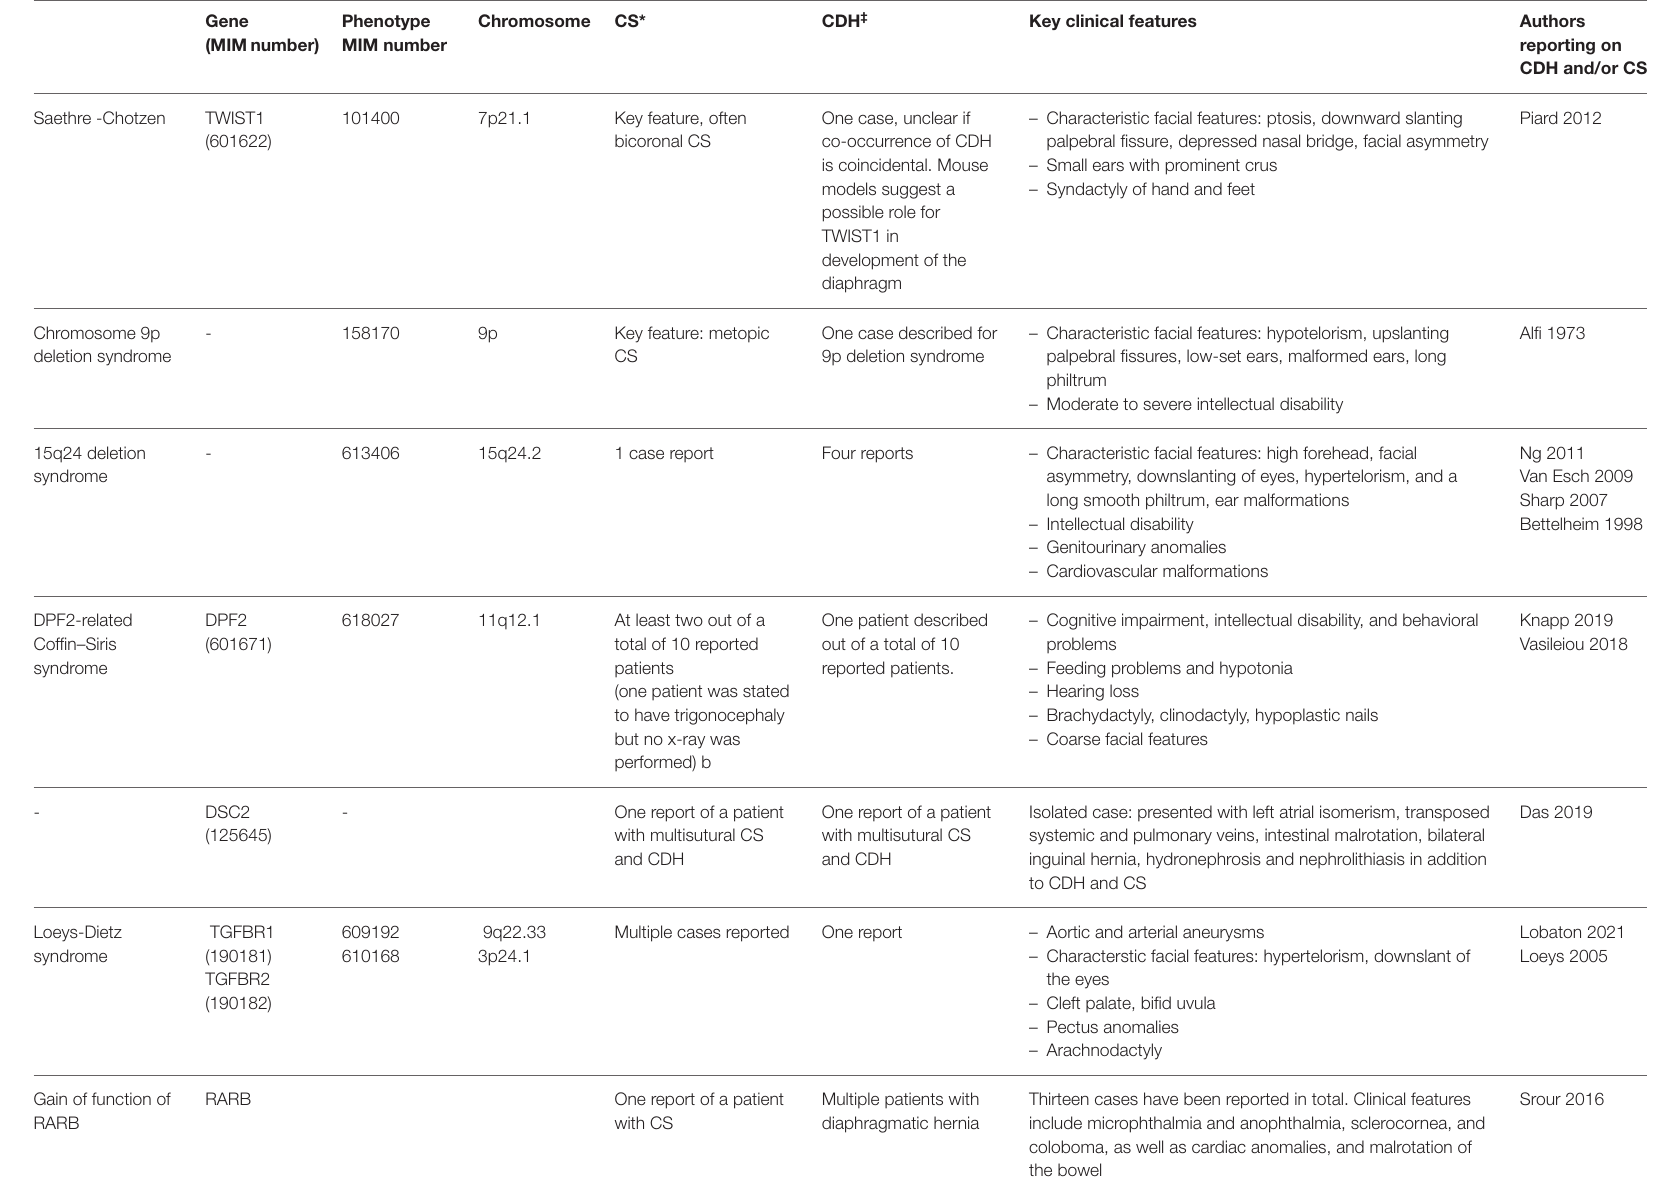
TABLE 2B | Isolated case reports on the co-occurrence of craniosynostosis and congenital diaphragmatic